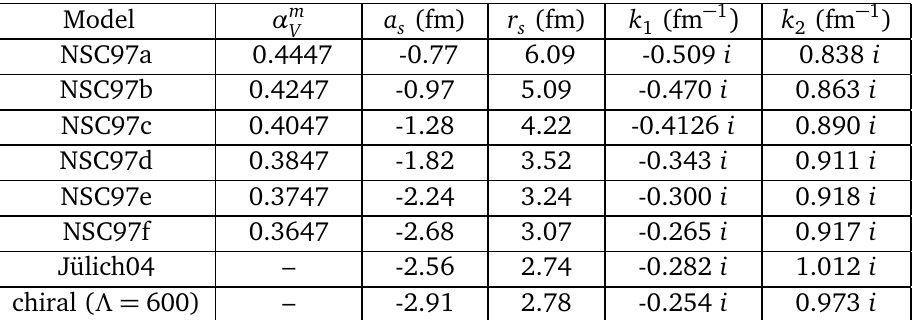
Table 3: The variation in the position of the poles k approximation for the Nijmegen NSC97 potentials [ 13,33 ] with changes in α m included for comparison are the values of k chiral potential with Λ = 600, [ 17 ]